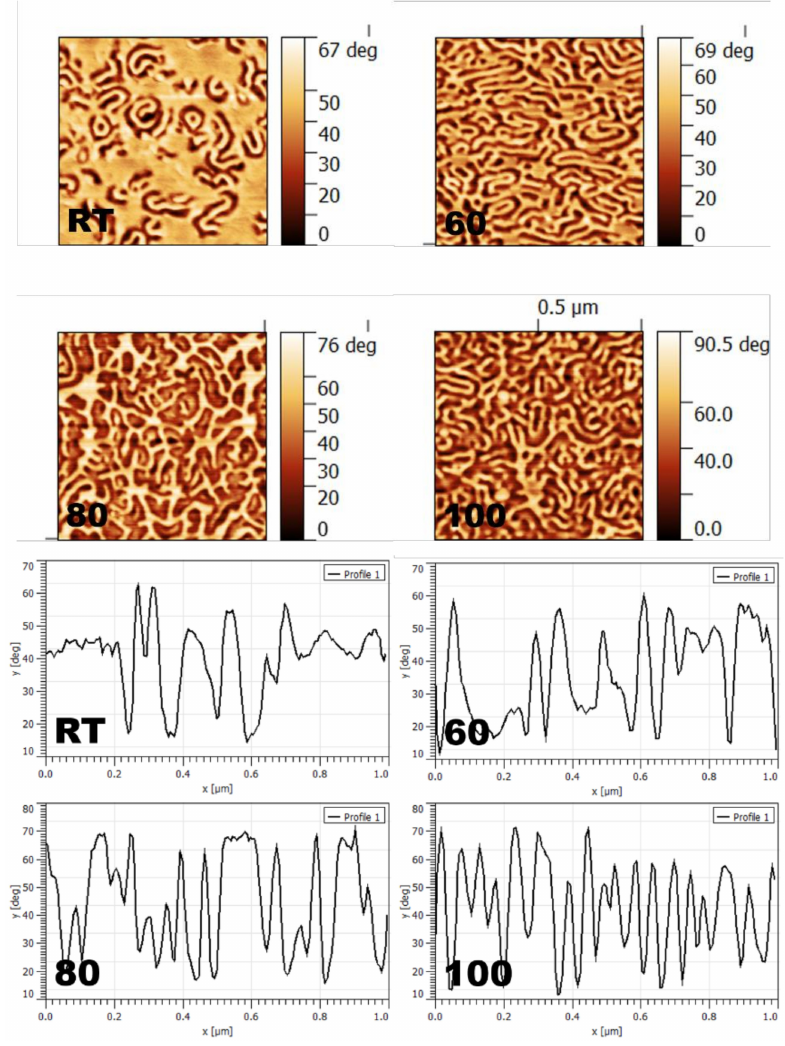
Figure 3. AFM phase images and corresponding cross-sections (1 µ m × 1 µ m) showing the evolution of the worm-like morphology with annealing temperature for the SEPS sample casted from a 3 wt% solution in